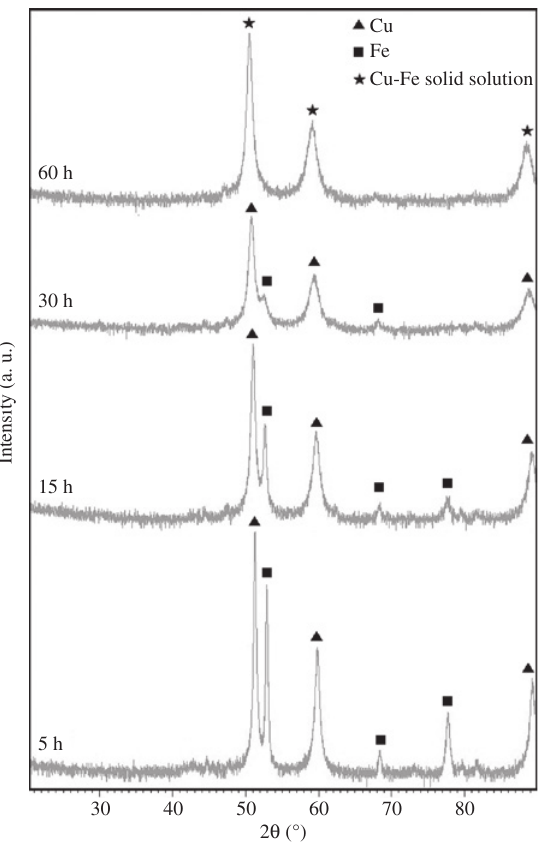
Fe after different durations of 75 25